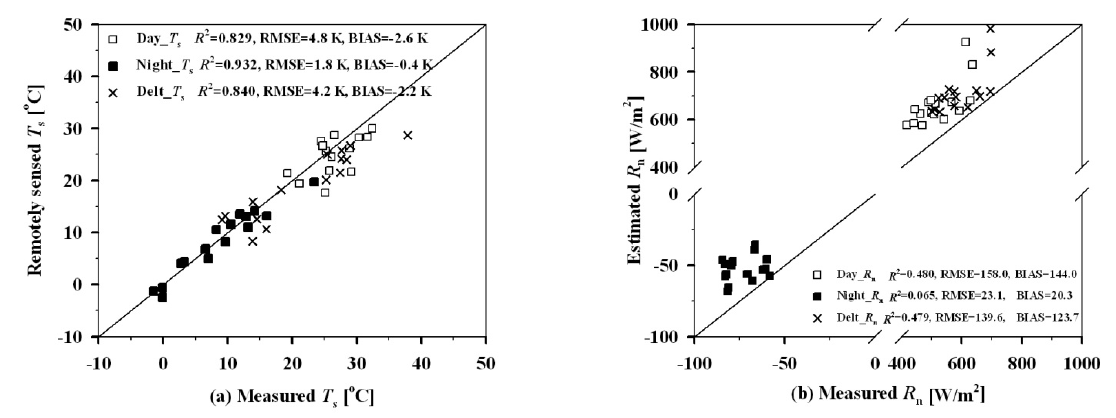
Figure 17. Comparisons of ( a ) T corresponding measurements from